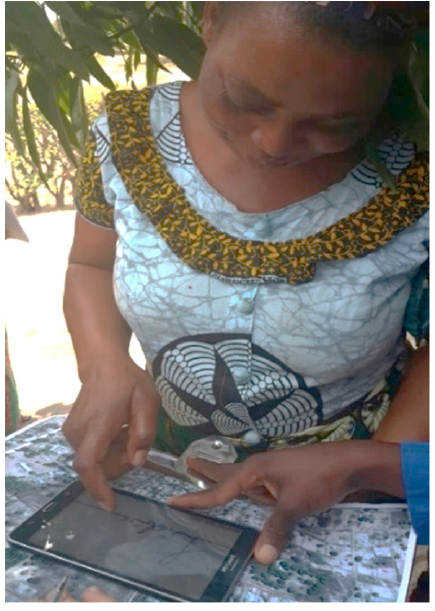
Figure 8. All parcels were validated by the local authority.